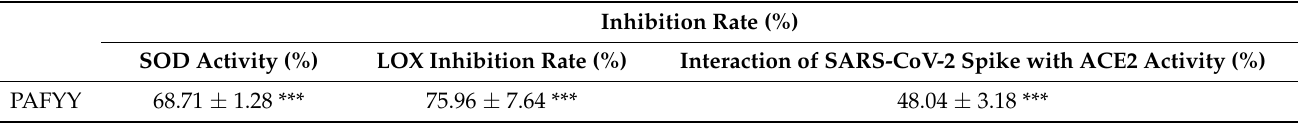
Table 3. Effect of PAFYY tea (100 mg/mL) on SOD, LOX, and SARS-CoV-2 spike with ACE2 interaction.